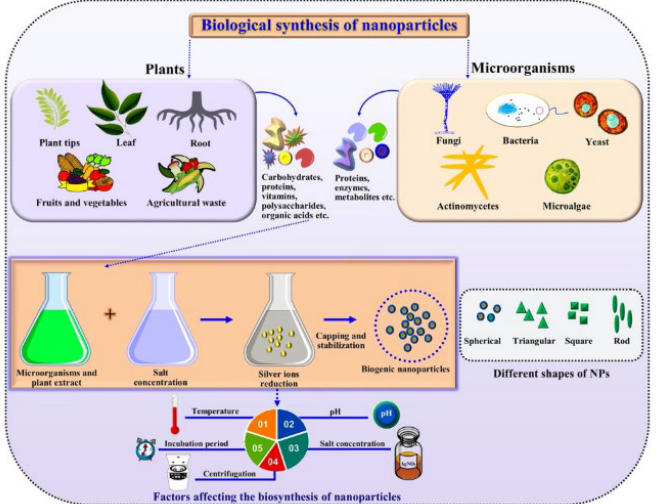
Figure 1. Generalized schematics of green synthesis of nanoparticles. Reprinted from Ref. [22].